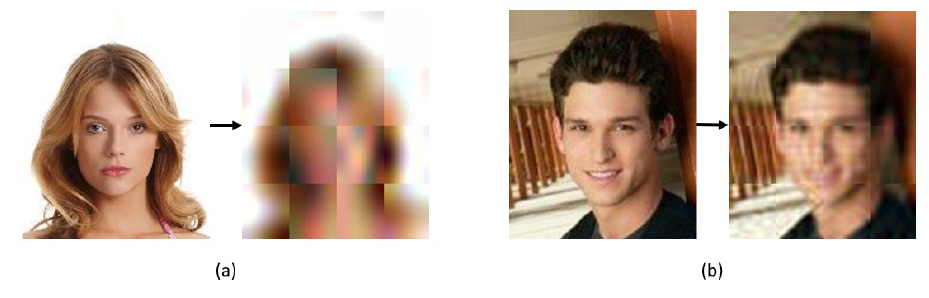
Figure 1. Overview of our DCC. ( a ) Face image is highly obfuscated by DCC ( a = b = 4, r = 32). ( b ) Face image is weakly obfuscated by DCC ( a = b = 4, r =